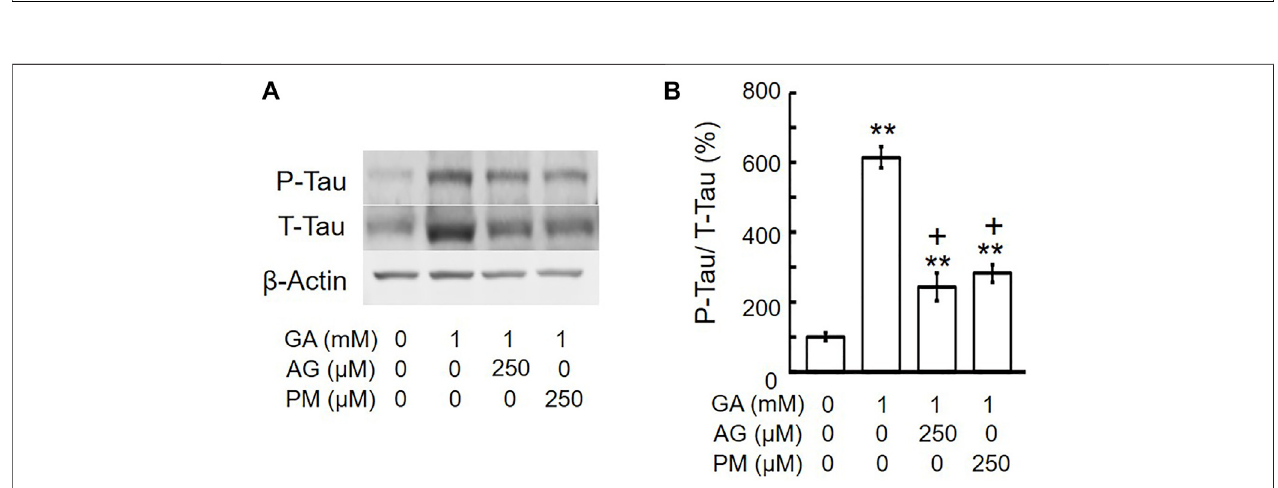
FIGURE 7 | AG or PM decreased the levels of tau-phosphorylation (P-Tau)/total tau (T-tau) by GA. (A) Western blot bands. (B) Graphical representation of tau- phosphorylation/total tau levels in the western blot. ** p < 0.01 vs. vehicle control, + p < 0.01 vs. GA alone ( n = 3).